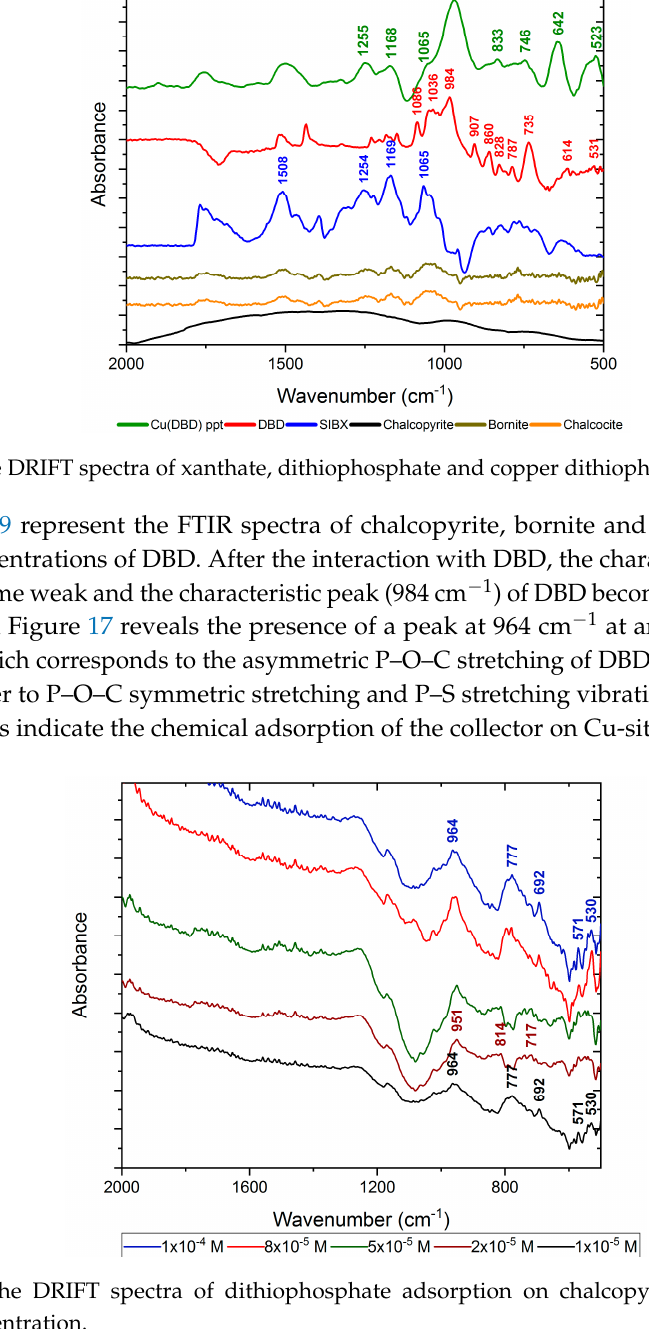
Figure 18. The DRIFT spectra of dithiophosphate adsorption on bornite with increasing collector concentration.